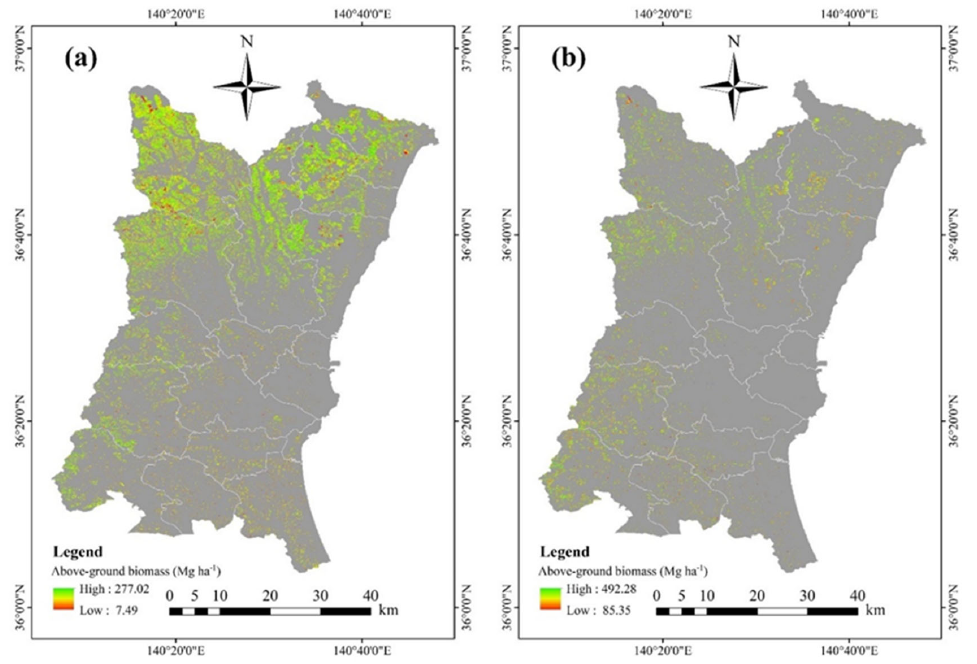
Figure 7. Spatial distribution of aboveground biomass (AGB) of ( a ) Japanese cedar and ( b ) Japanese cypress in the targeted cities in Ibaraki Prefecture.